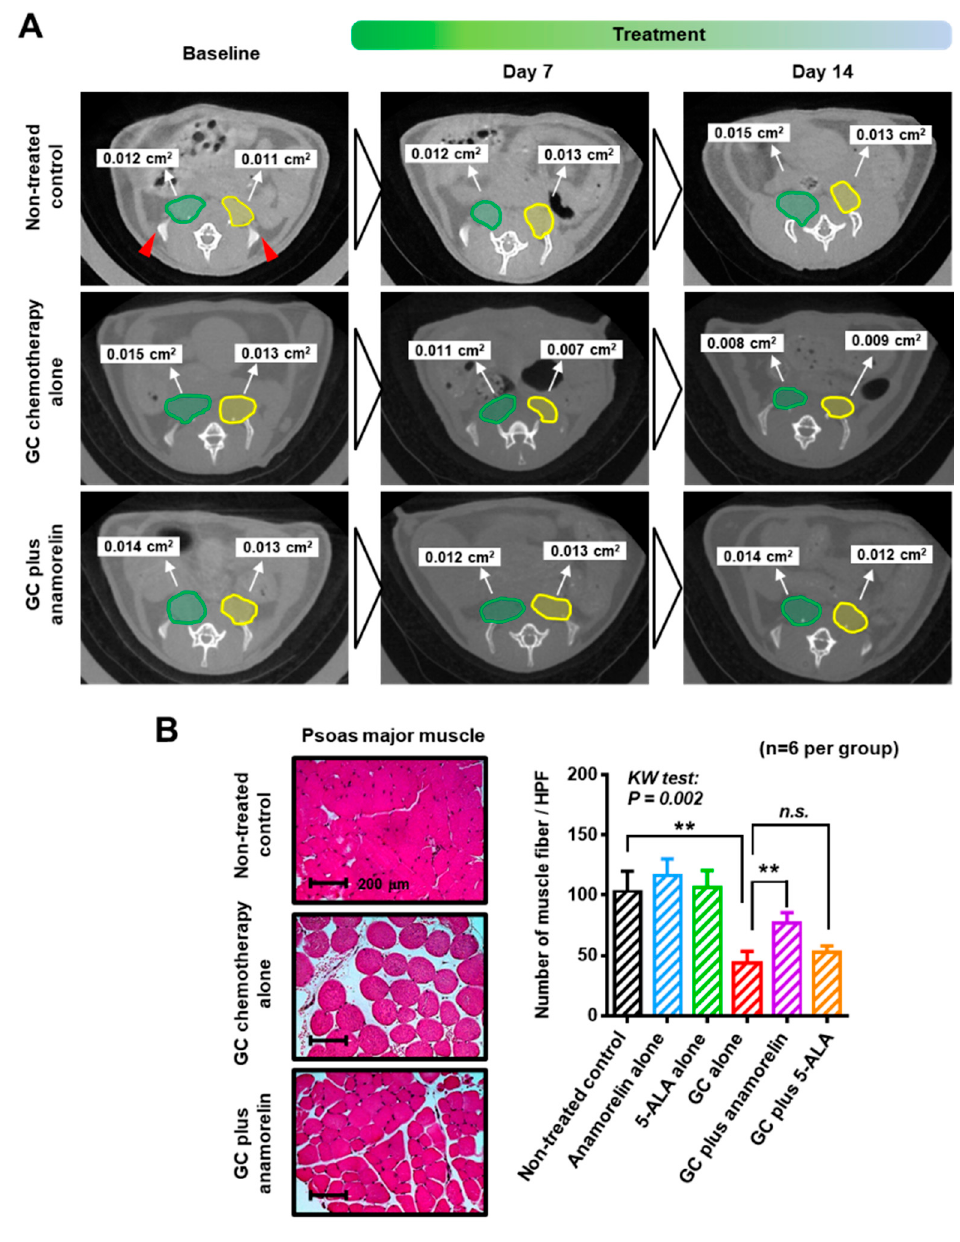
Figure 2. Changes in skeletal muscles owing to chemotherapy. ( A ) Measurement of the cross-sectional area of the bilateral psoas major muscle at the level of the top of iliac bones (red triangles) was performed using a combination of computed tomography and NIH Image J. Right (green ellipse) and left (yellow ellipse) psoas major muscles were measured separately and summed. ( B ) Representative hematoxylin and eosin staining images are shown for the non-treated control, gemcitabine and cisplatin chemotherapy (GC) alone, and GC plus (continued) anamorelin groups. Original magnification: 200 × . Quantifying HE-stained muscle mass was performed with Image J. The number of muscle fiber per high power field (HPF) was counted and compared among the treatment groups by the Kruskal-Wallis test and the post-hoc test (Dunn test). Abbreviations: 5-ALA—5-aminolevulinic acid; GC—gemcitabine and cisplatin combination chemotherapy; CT—computed tomography; HE—hematoxylin & eosin .